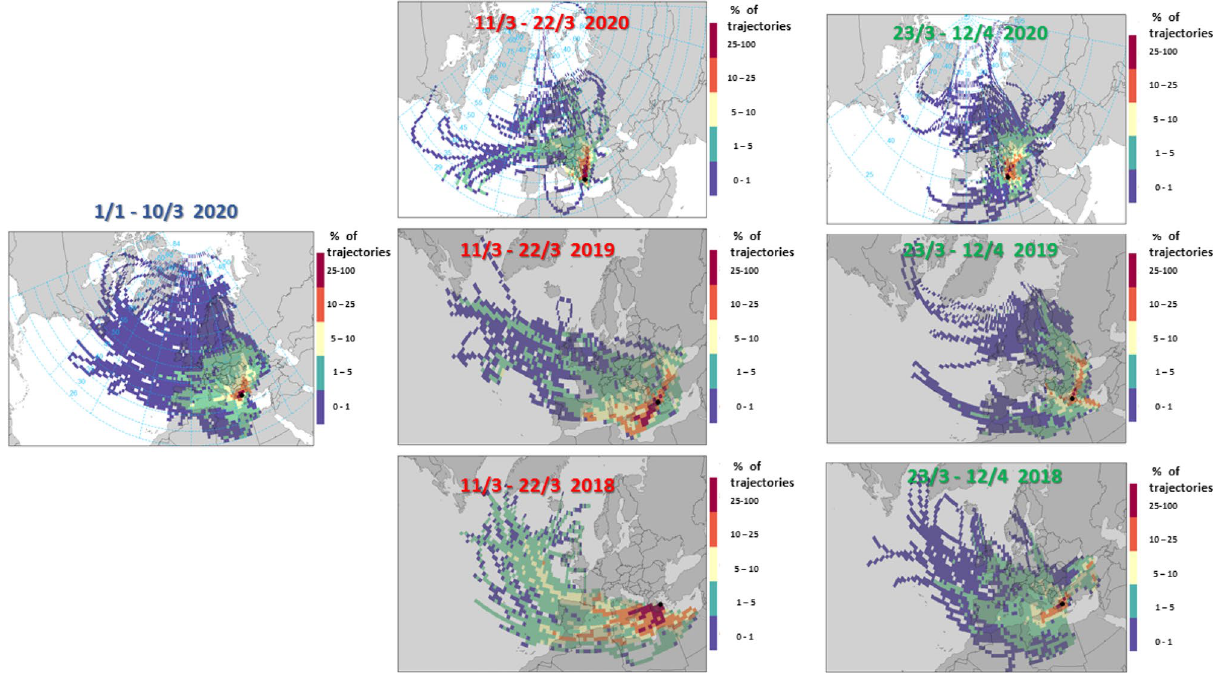
Figure 2. Frequency of spatial origin for air masses arriving at Athens from the greater Region during the proposed reference period (1/1–10/3, 2020) the two lockdown periods under consideration (11/3–22/3, 2020 & 23/3–12/4, 2020) and the respective periods in 2018 and 2019 (Created by R version 4.0.2 27 and Openair version 2.7–7 28